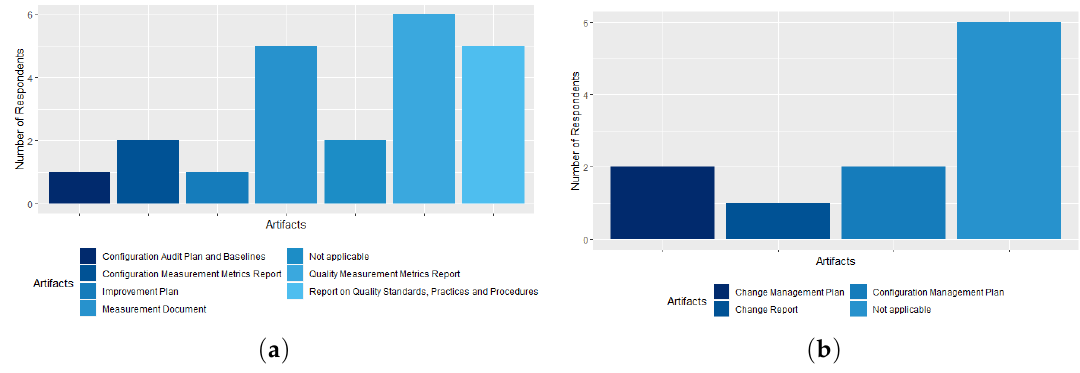
Figure 13. ( a ) The software development process (Quality Management, Configuration) artifacts; ( b ) the Change Management Process artifacts.